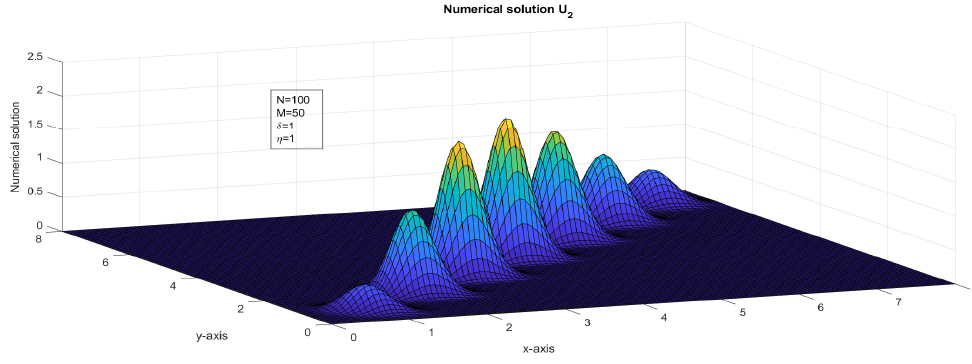
Figure 12. The surface plot illustrates the numerical solution, U 2 , for Case 1 in Example